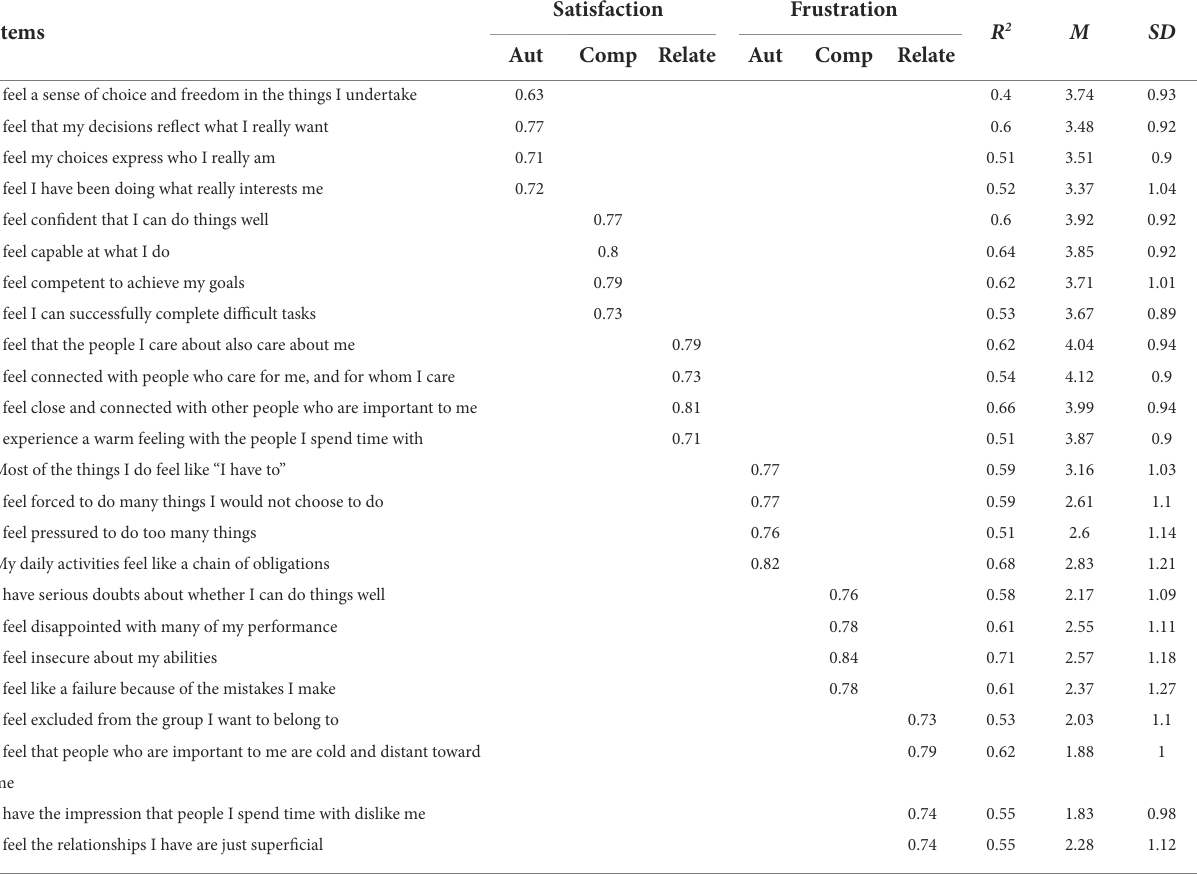
TABLE 3 Factor loadings, communalities, items means, and standard deviations of the 6-factor CFA. Items